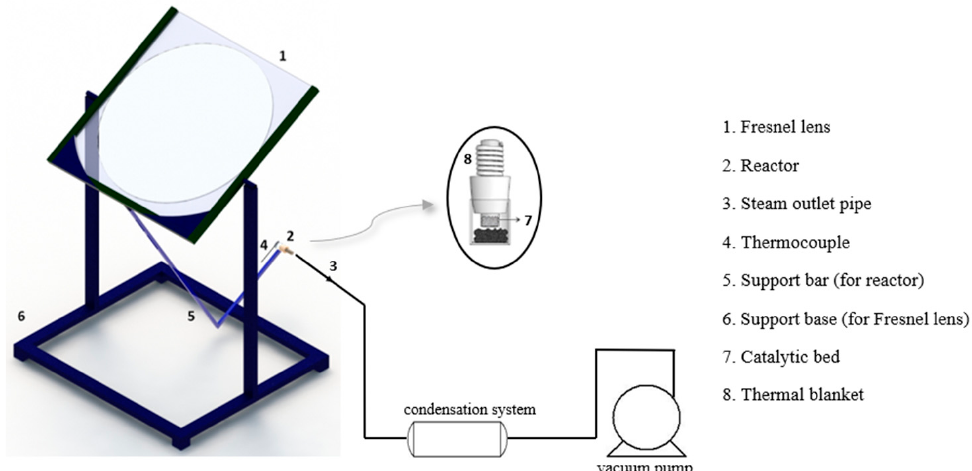
Figure 1. Schematic representation of the experimental apparatus used in solar pyrolysis.